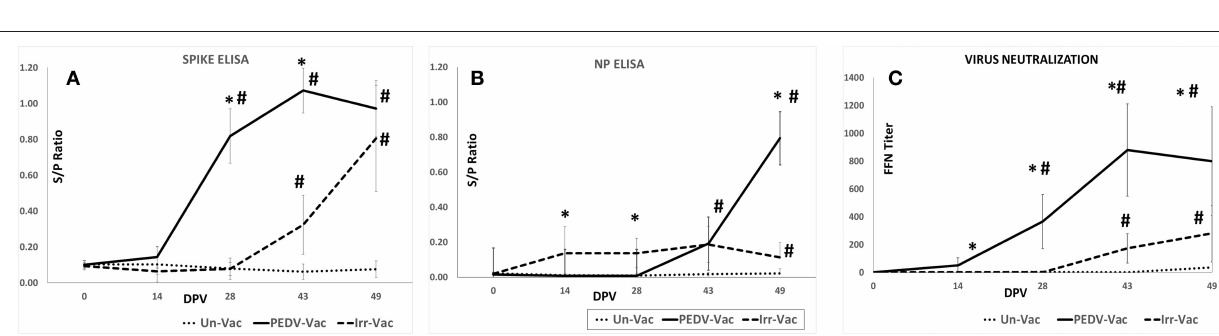
FIGURE 3 | Serological responses to vaccination: (A) Antibody responses to the PEDV spike protein as assessed by ELISA (B) . Antibody responses to the PEDV nucleoprotein as assessed by ELISA (C) . Virus neutralizing antibody responses as assessed by a fluorescent focus neutralization (FFN) assay. X axis, Days post vaccination; Y axis, ELISA OD value expressed as a signal to positive control ratio; Line with dots, Unvaccinated controls; Solid line, Heat and RNAse treated vaccine; Dashed line, Irradiated vaccine. Mean duplicate values for 8 pigs and standard deviations are presented. *Significantly different from the unvaccinated group, # Significantly different from the other vaccine group. * p < 0.05 by the Student’s T